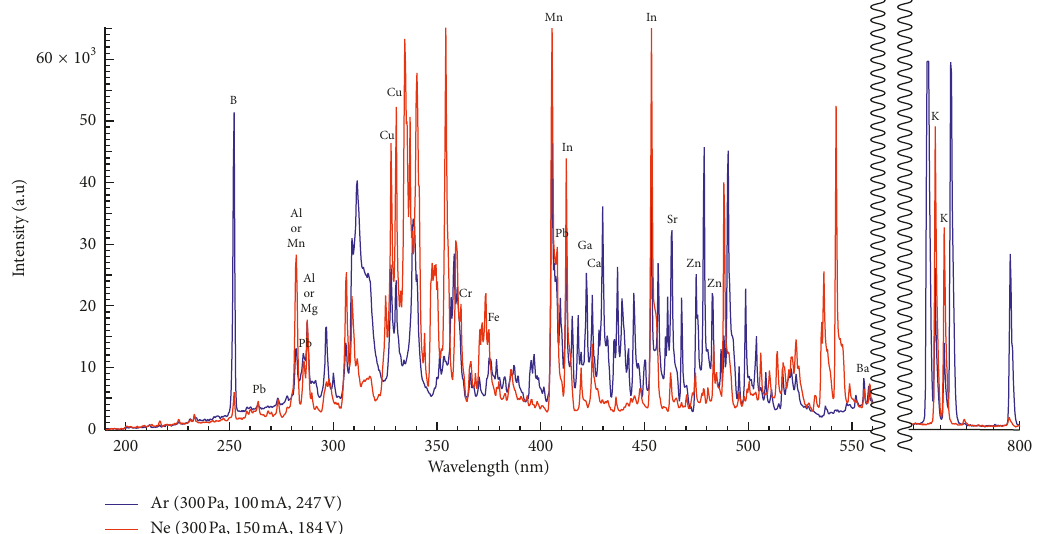
Figure 5: Mixed elements standard sample liquid residue emission spectrum.